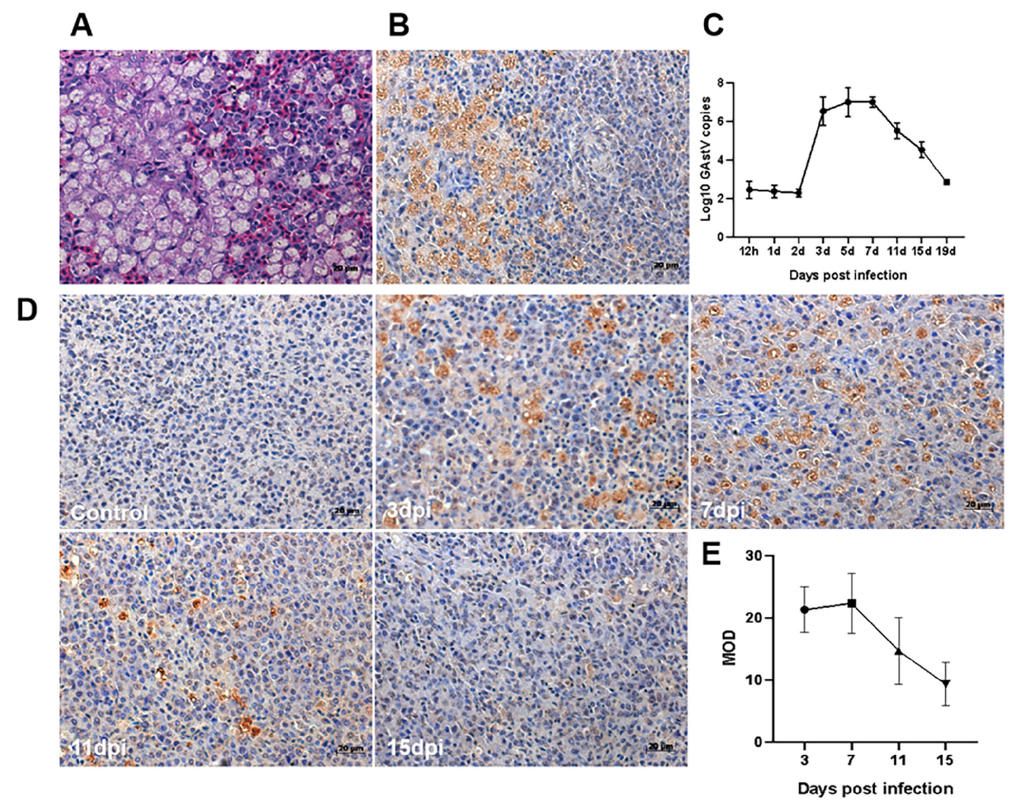
Figure 5. Virus location and viral load in the spleen. Spleen tissue was stained with hematoxylin and eosin (HE) ( A ), and the virus location was detected by IHC ( B ). Viral copy numbers in spleens in goslings infected with GNAstV were evaluated using real-time PCR ( C ). The virus location was detected by IHC ( D ), and the mean optical density (MOD) was calculated by Image-Pro Plus ( E ). Scale bar: 20 µ m. Values are expressed as mean ± SD, n = 5.